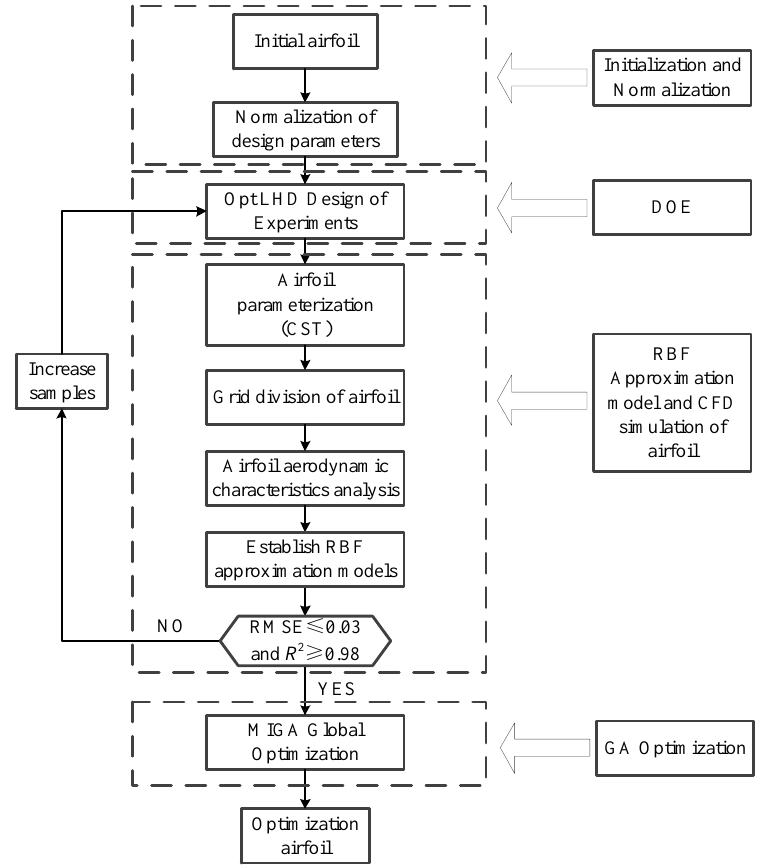
Figure 17. Optimization process of airfoil. LHD: Latin hypercube design; RBF: radial basis functions.